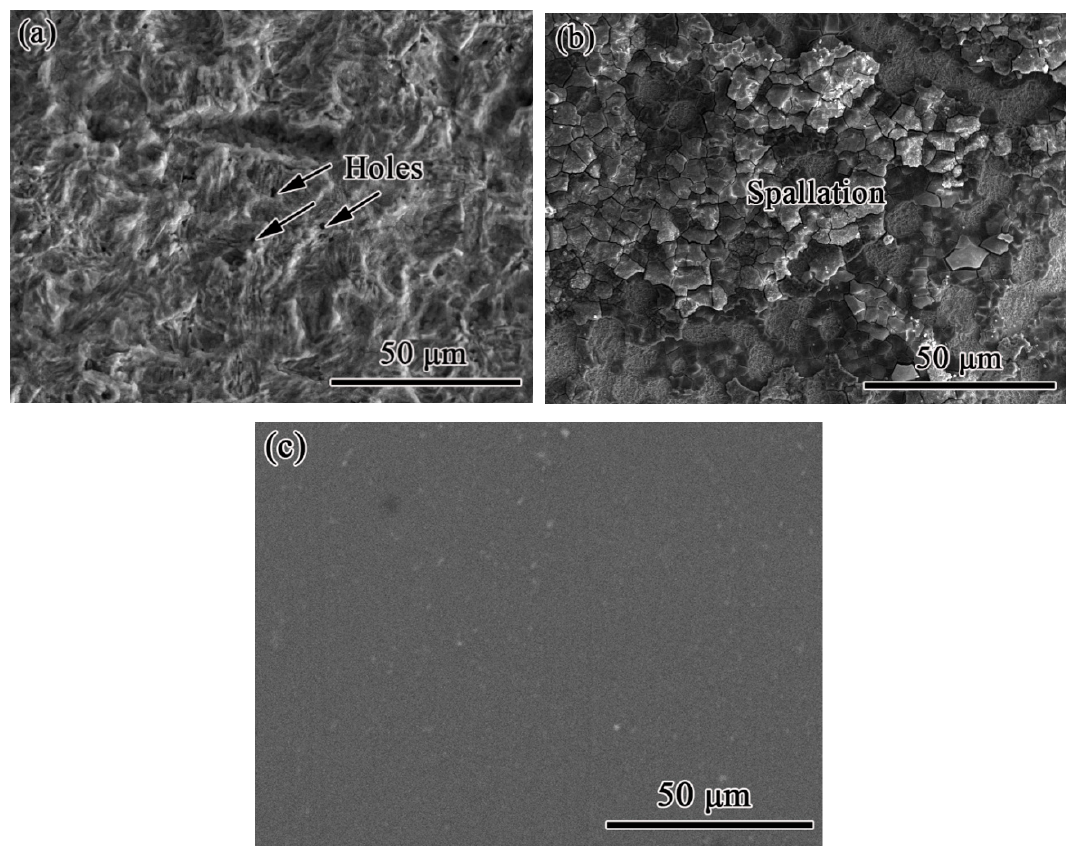
Figure 5. Surface morphologies of the uncoated ( a ), LS ( b ) and HS ( c ) samples after corrosion in the 0.5 M HCl solution at 30 °C for three days.